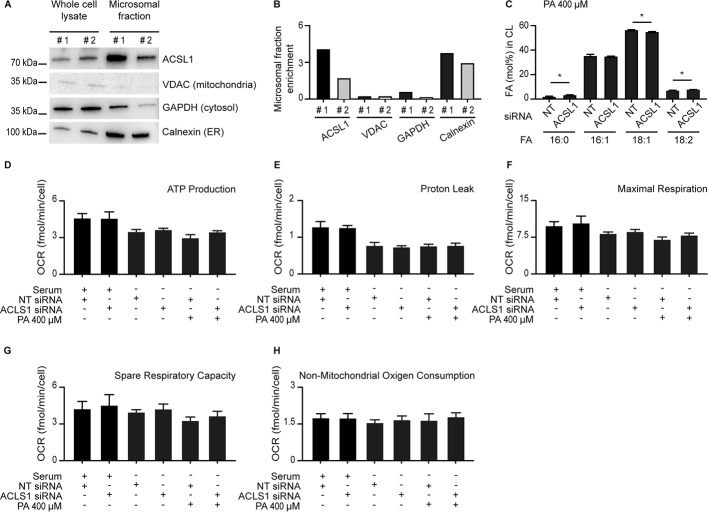
Some ACSL1 is enriched in the microsomal fraction and evidence that mitochondria respiration is still functional when ACSL1 is silenced.(A) Western blot showing that ACSL1 is slightly enriched in the microsomal fraction purified from HEK293 cells. The VDAC, GAPDH and Calnexin proteins were also detected as markers of mitochondria, cytosol and ER, respectively. (B) Quantification of the blot in A. (C) Abundance of different FAs among CLs in HEK293 treated with non-target (NT) or ACSL1 siRNA. (D–H) Respiration parameters in HEK293 cells pre-treated with the indicated conditions prior to the Seahorse analysis. All PA treatments used 400 μM for 24 hr. Statistically significant differences from control are indicated, where *: p<0.05.Figure 7—figure supplement 1—source data 1.Lipidomics data for panel C.